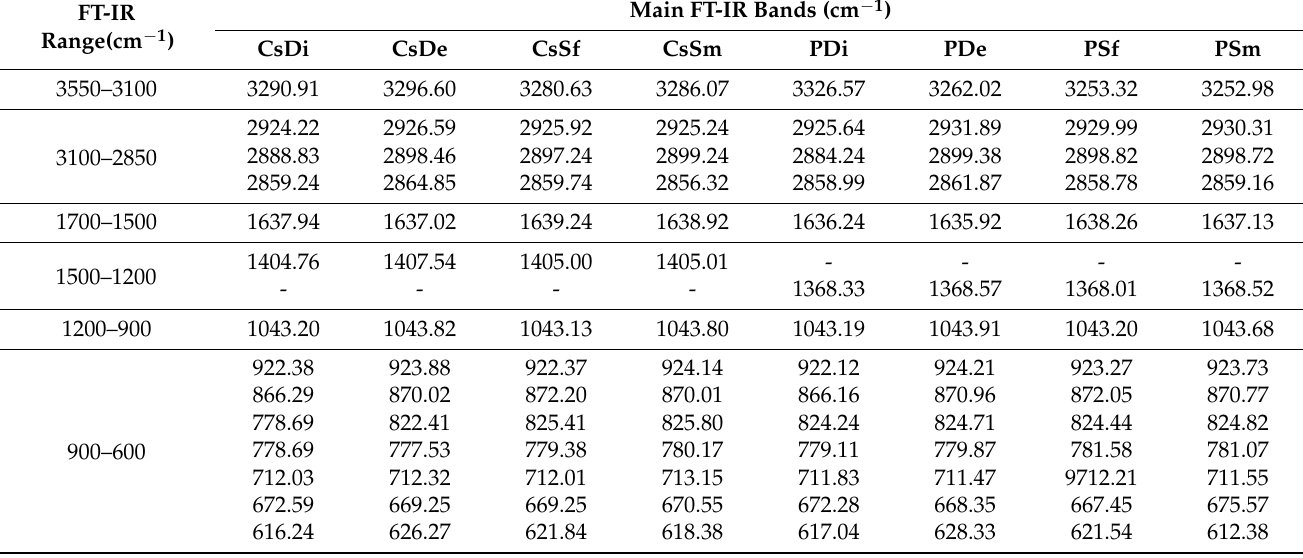
Table 4. The main recorded FT-IR ATR bands on 4000- 600 cm − 1 range.